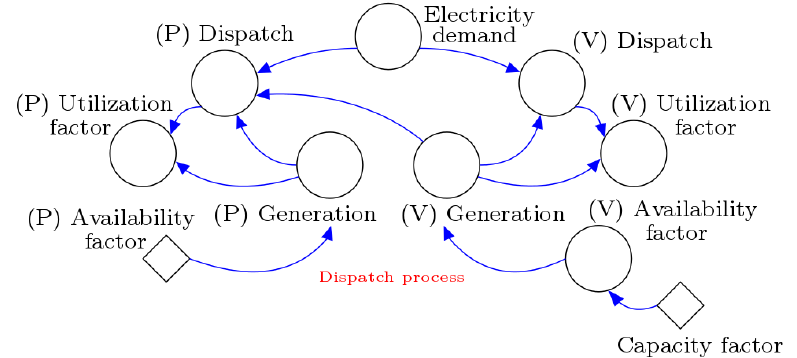
Figure 5. Electricity